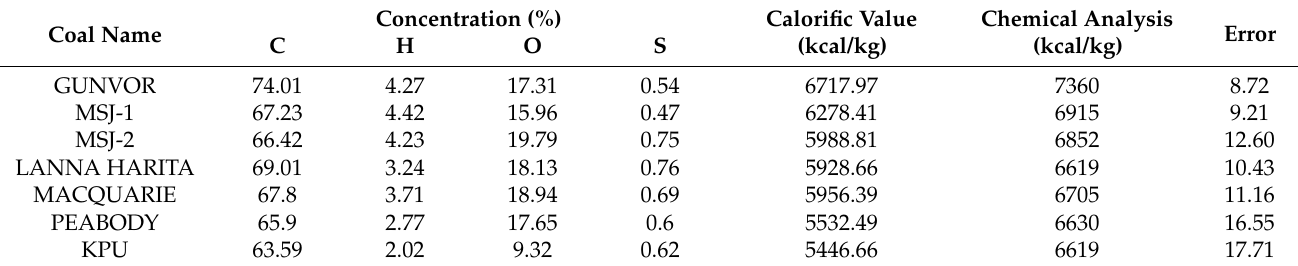
Table 3. Predicted calorific value of various coal samples by partial least squares.